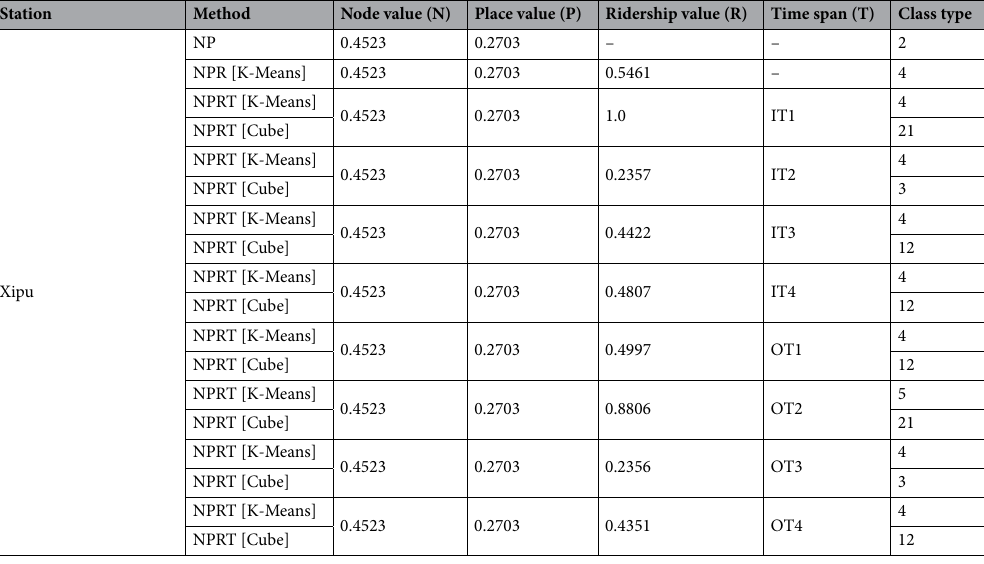
Table 10. Stations classification results (NP, NPR,